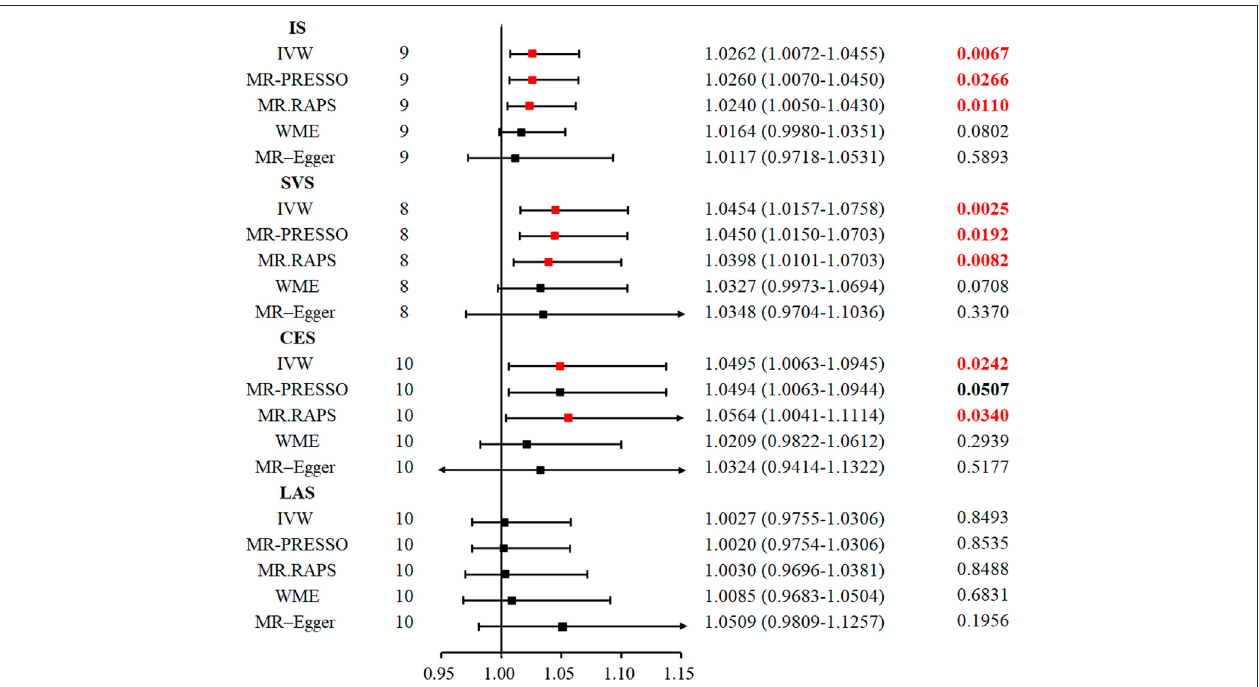
FIGURE 2 | Five methods to assess the causal role of TIMP-3 in the risk of IS and its subtype. CI = con fi dence interval, IVW = inverse-variance-weighted, MR = Mendelian randomization, OR = odds ratio, SNP = single nucleotide polymorphism, IS = ischemic stroke, LAS = large vessel ischemic stroke, CES = cardioembolic ischemic stroke, SVS = small vessel ischemic stroke, MR. RAPS = MR-Robust Adjusted Pro fi le Score, MR-PRESSO = MR pleiotropy residual sum and outlier.